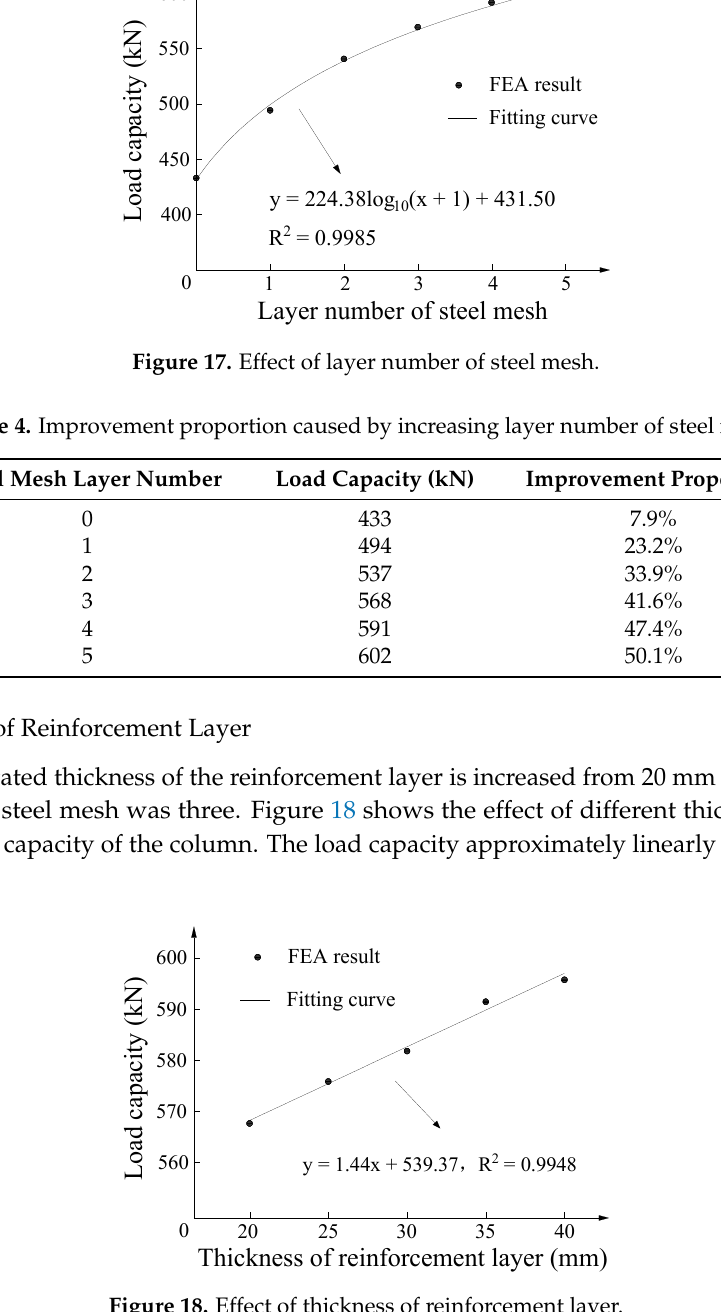
Figure 18. Effect of thickness of reinforcement layer.